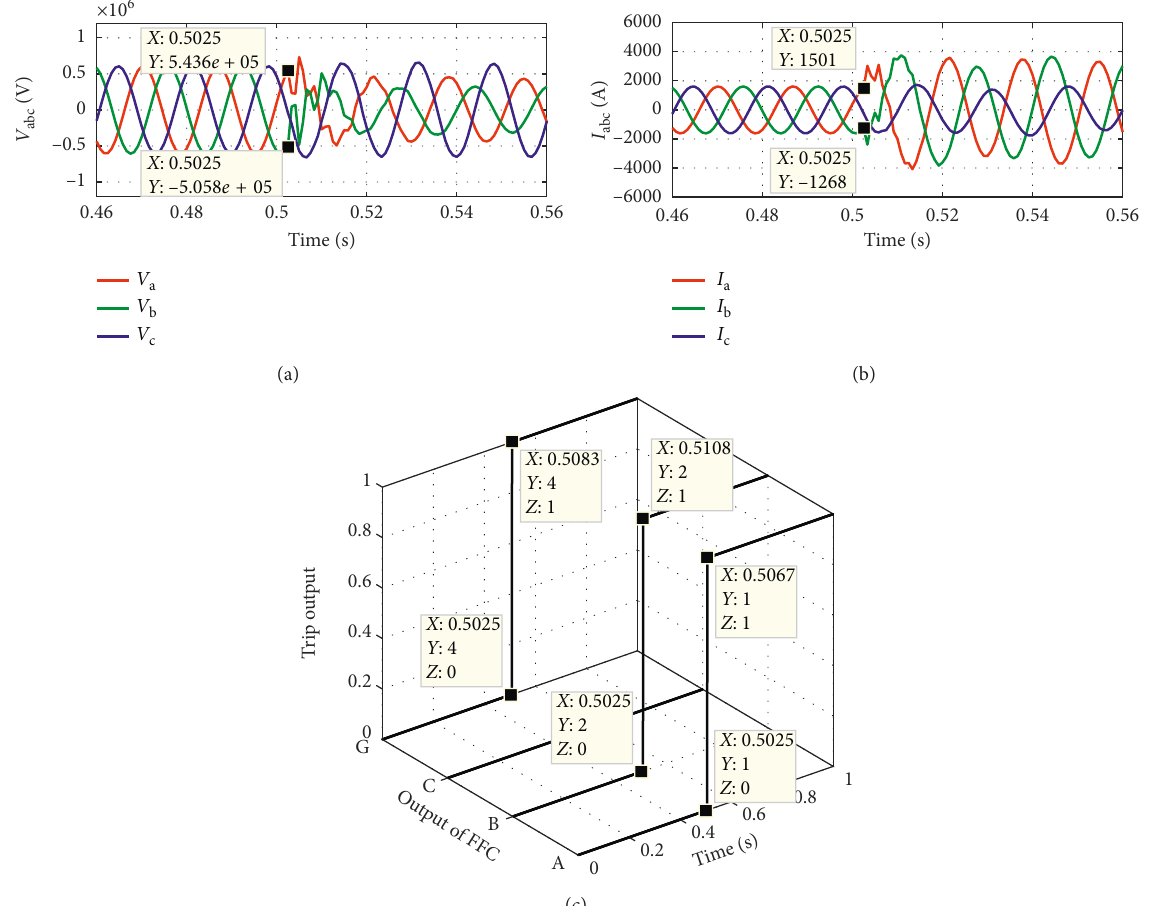
Figure 5: Performance during ABG fault at 205km, FIA � 45 ° , and FR � 40 Ω : (a) 3-phase voltage waveform; (b) 3-phase current waveform; (c) output of Table 6: Effect of FIA (FR � 50 Ω ). Simulated system data Results obtained from the proposed CDFTF-based scheme